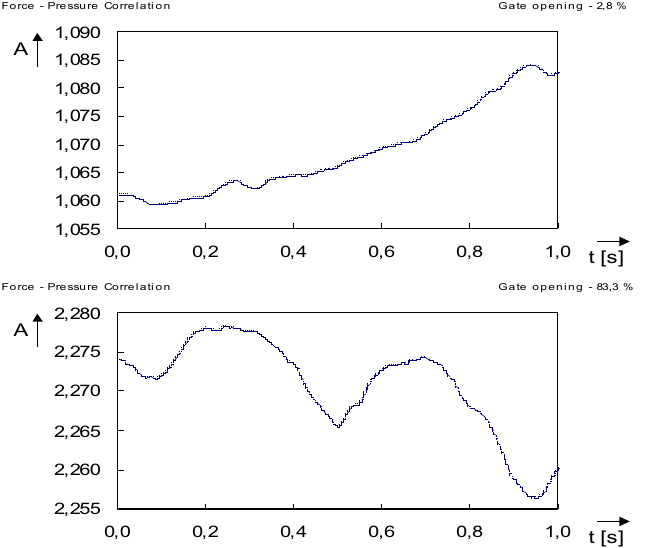
Fig. 8. Correlation record between acting force and flow pressures in the draft tube.